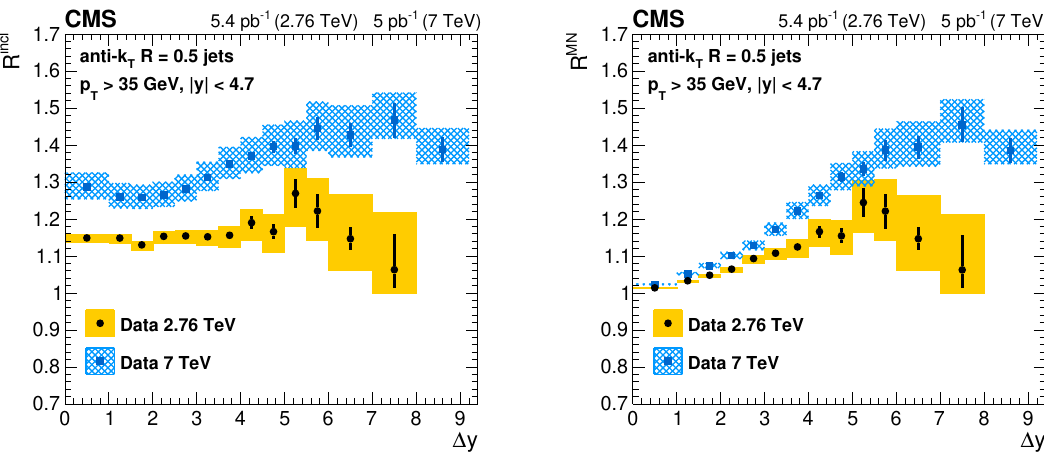
Figure 8 . Ratios R incl (left) and R MN (right) of the cross sections for inclusive (left) and MN (right) and “exclusive” dijet production, measured at 2.76 TeV and 7 TeV [21] collision energies. The systematic uncertainties are indicated by the shaded bands and the statistical uncertainties by the vertical